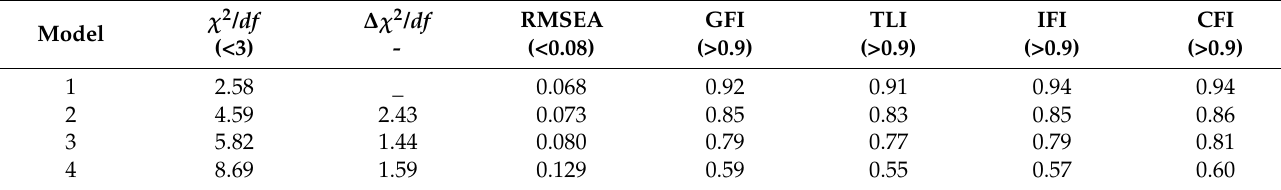
Figure 2. Measurement model.